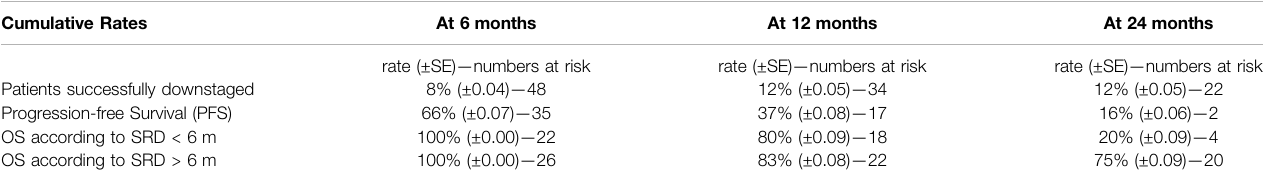
TABLE 3 | Time-to-event outcomes as indicated in the related survival plots ( Figures 1 , 2 ).